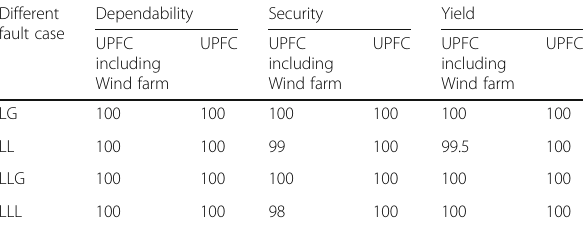
Table 6 A Comparison of UPFC including wind-farm Different fault